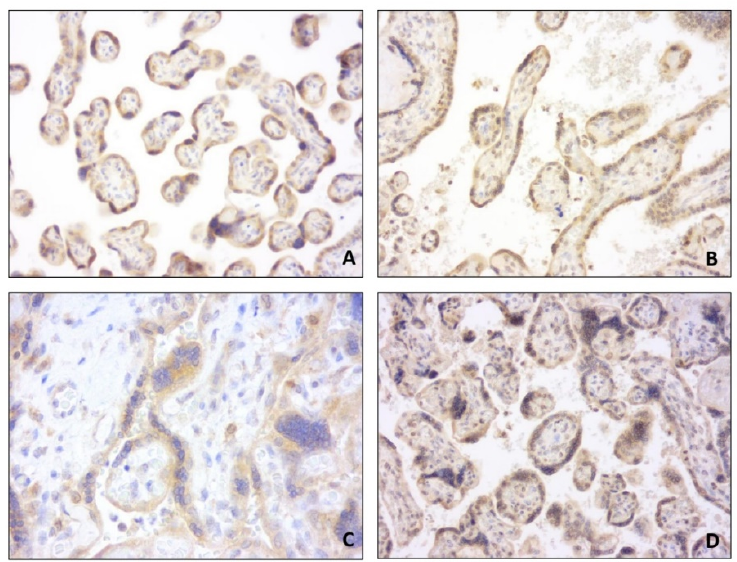
Figure 2. PTH-R1 ( A ) and PTH-rP ( B ) expression in villous cytotrophoblast; PTH-R1 ( C ) and PTH-rP ( D ) expression in syncytiotrophoblast.